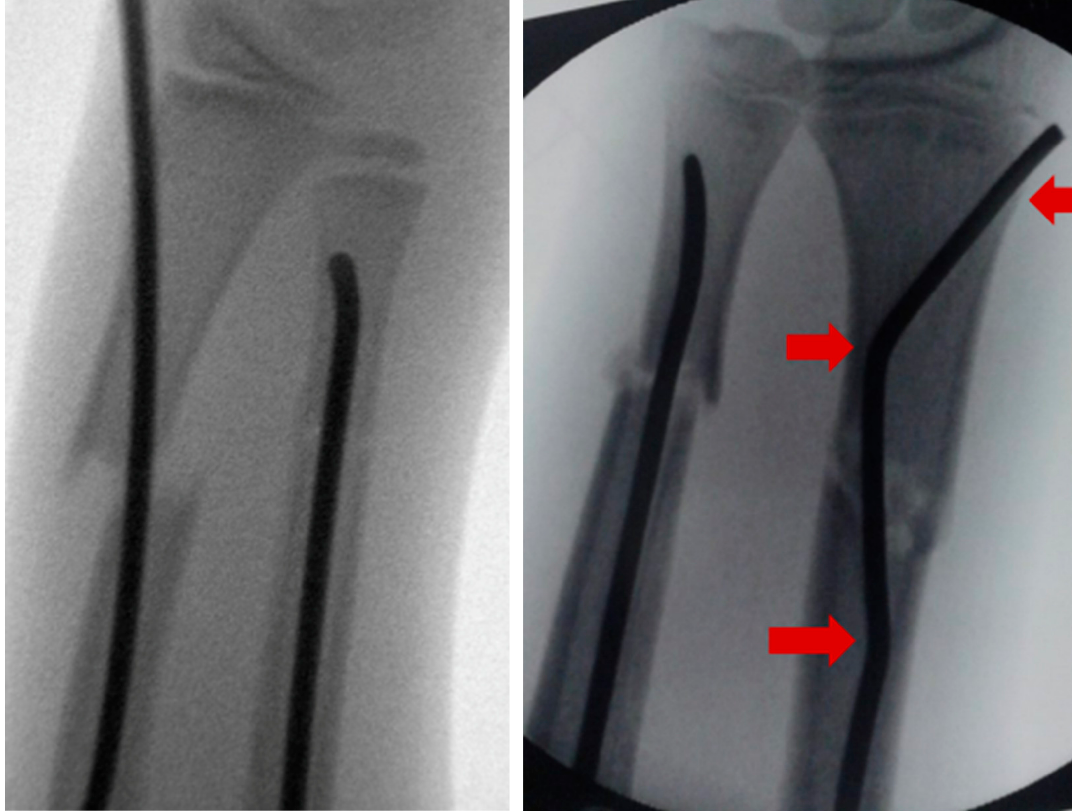
Figure 1. Intramedullary nailing without pre-bending of the radial nail leading to a radial displace- ment of the distal fragment whereas double pre-bent nail ensures three-point support.